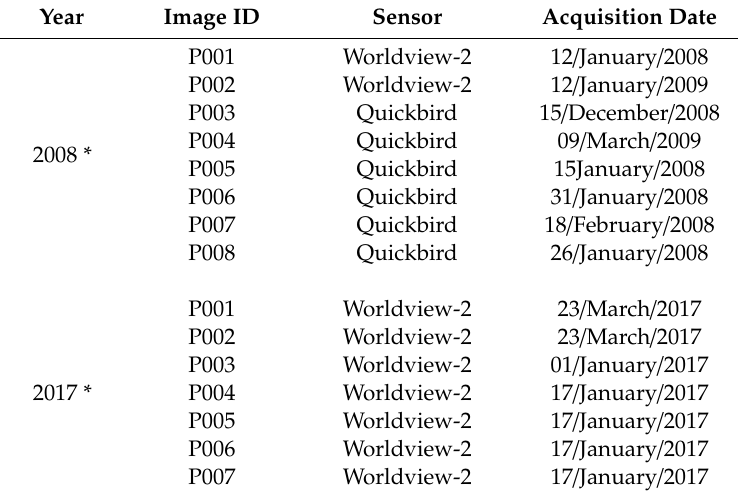
Table 1. Acquisition dates of the images of the time